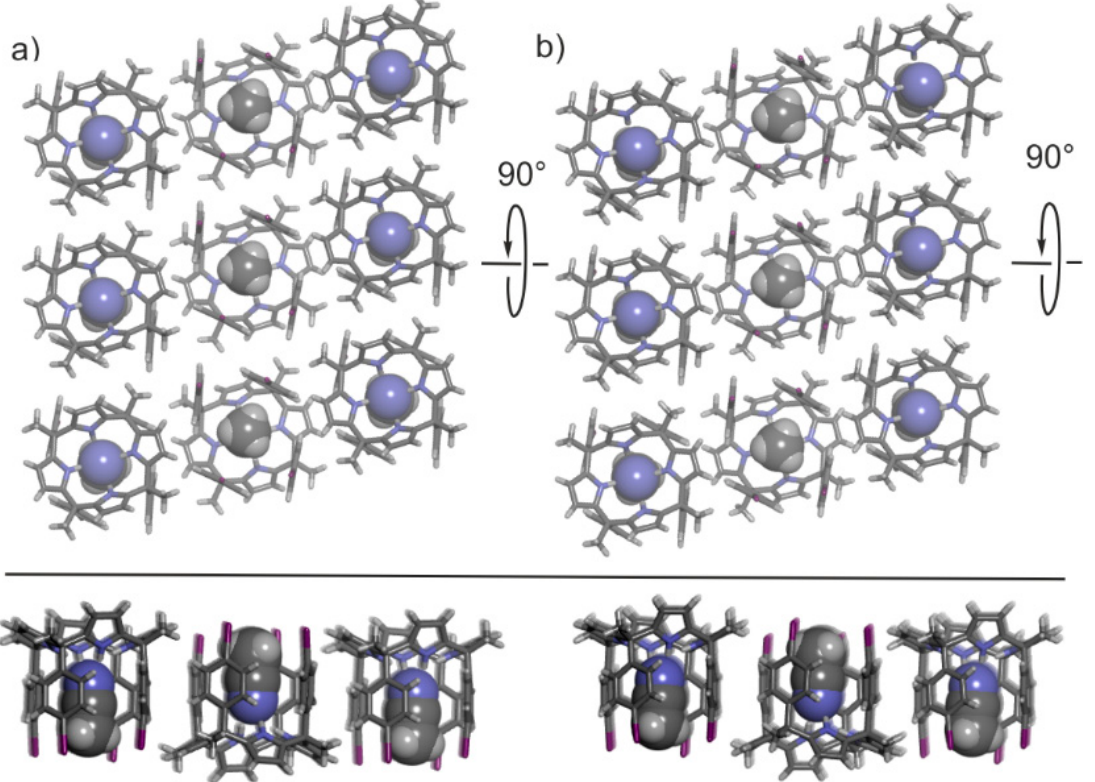
Figure 2. Top and side views of restricted packing of the lattices in polymorphs A ( a ) and B ( b ). The rods (columns) formed by CH 3 CN@calix[4]pyrrole inclusion complexes display a unidirectional orientation of p -iodo substituents. In turn, the rods pack in almost identical 2D layers with having an alternating orientation of inclusion complexes (antiparallel). The calix[4]pyrroles are shown in stick representation and the included acetonitrile molecules as Corey-Pauling-Koltun (CPK) models.